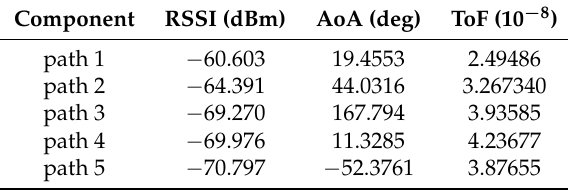
Table 2. Parameter values of the multipath